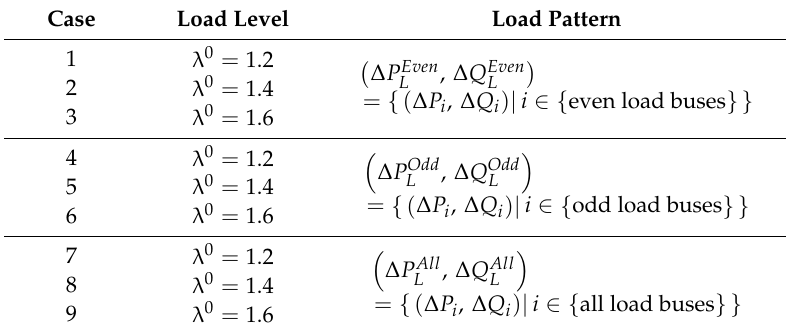
Figure 10. Estimation of system VSM for IEEE 14-bus model. 4.1.2. IEEE 30-Bus Model The proposed method is applied to the IEEE 30-bus model, depicted in Figure 11. This test model contains 30 buses, 6 generation units, 24 loads, and 41 transmission lines [22].